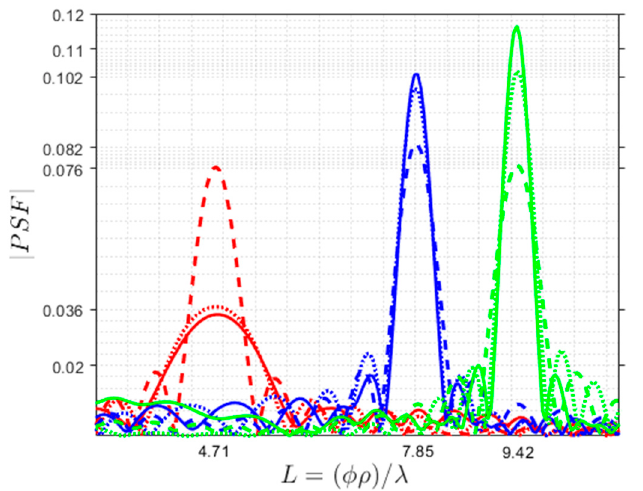
Figure 5. Comparison of the actual PSFs of three sensing modes for φ 0 = π /2 (red lines), φ 0 = 5 π /6 (blue lines), φ 0 = π (green lines). The solid, dotted, and dashed lines indicate the reflection, transmission, and angle modes.